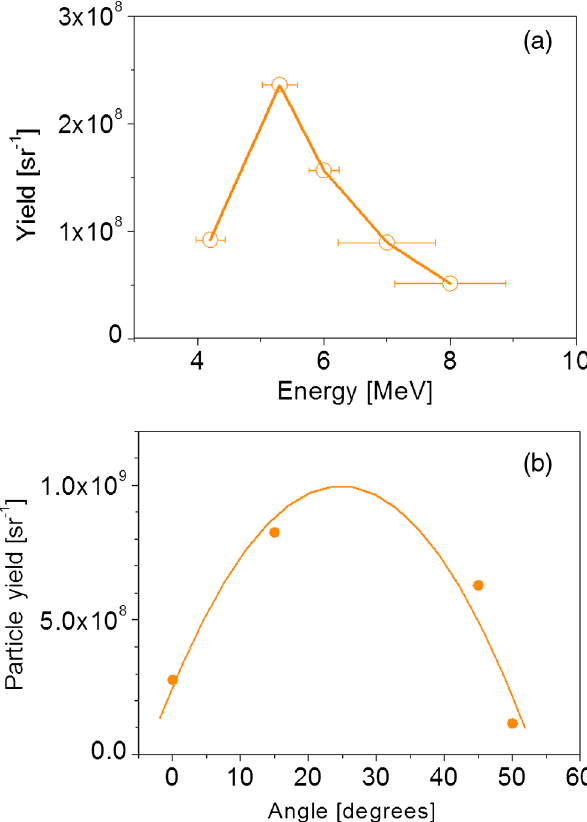
FIG. 4. (a) Alpha-particle energy distribution obtained from PM-355 analysis using detectors with different Al filter thick- nesses ( 6 – 20 μ m) and placed at an angle of about 45° with respect to the laser-incident direction in the same laser shot. (b) Alpha- particle angular distribution obtained from PM-355 analysis using detectors placed at different angles with respect to the laser-incident direction in the same laser shot.